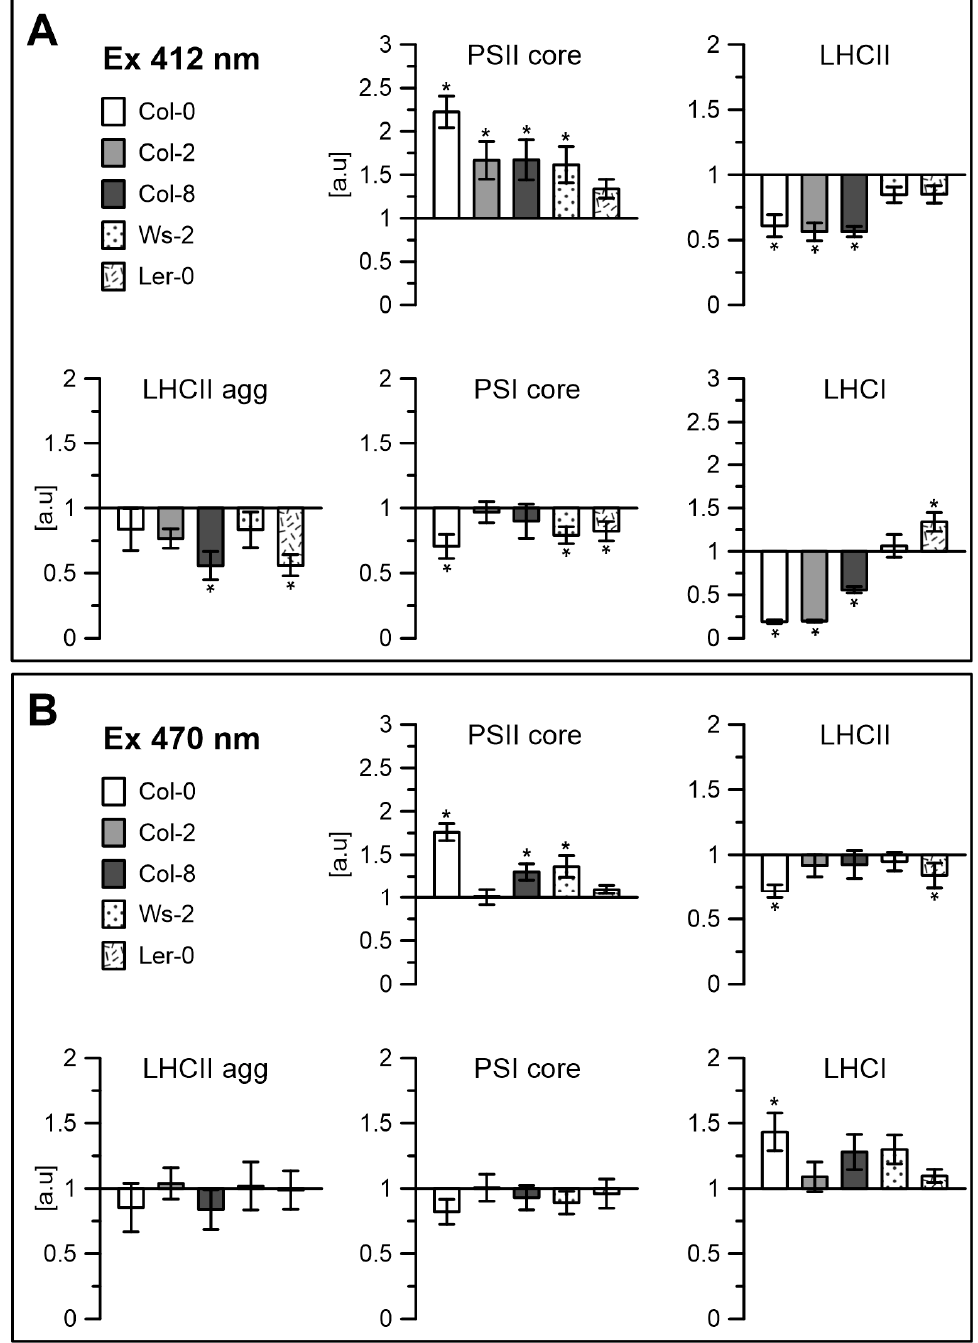
Figure A2. Contribution of the components: PSII core, LHCII, LHCII aggregates, PSI core and LHCI, divided using the Gaussian curve-fit, from the fluorescence emission spectra at 77 K (Figure 2A), excited at 412 nm ( A ) and 470 nm ( B ). * is p =